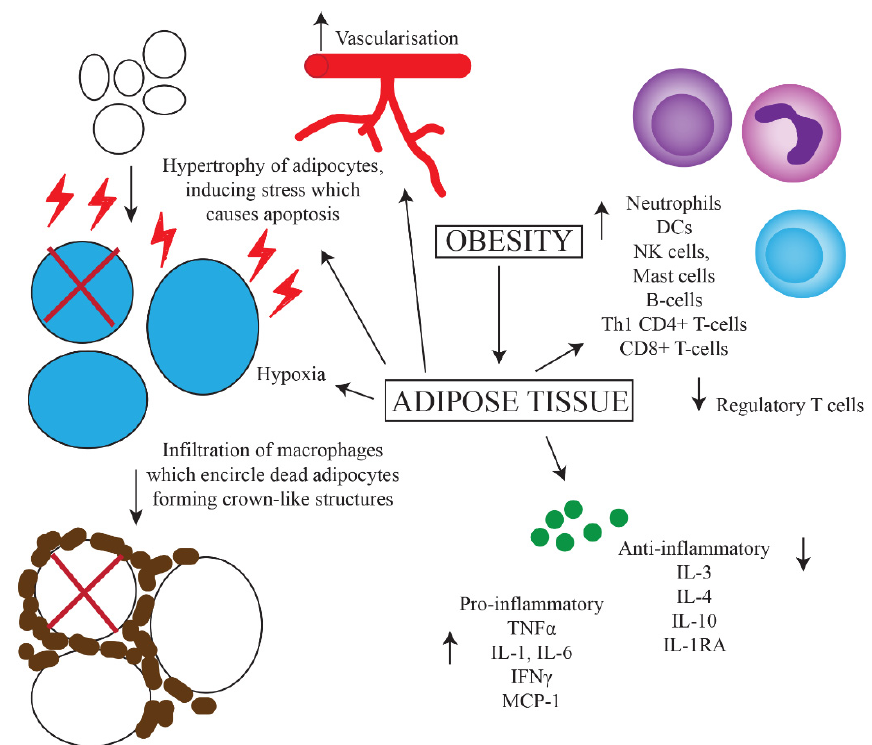
Figure 1. Predominant mechanisms of chronic inflammation caused by obesity. Increased uptake of nutrients leads to greater storage of fats and hence hypertrophy of adipocytes. This results in increased intracellular stress and upregulation of apoptotic genes, leading to apoptosis. Increased vascularization, hypoxia, cell death and upregulation of MHC-II on adipocytes leads to the influx of various inflammatory cells including macrophages, which surround dead adipocytes forming crown- like structures. There is also increased secretion of pro-inflammatory, and decreased secretion of anti- inflammatory